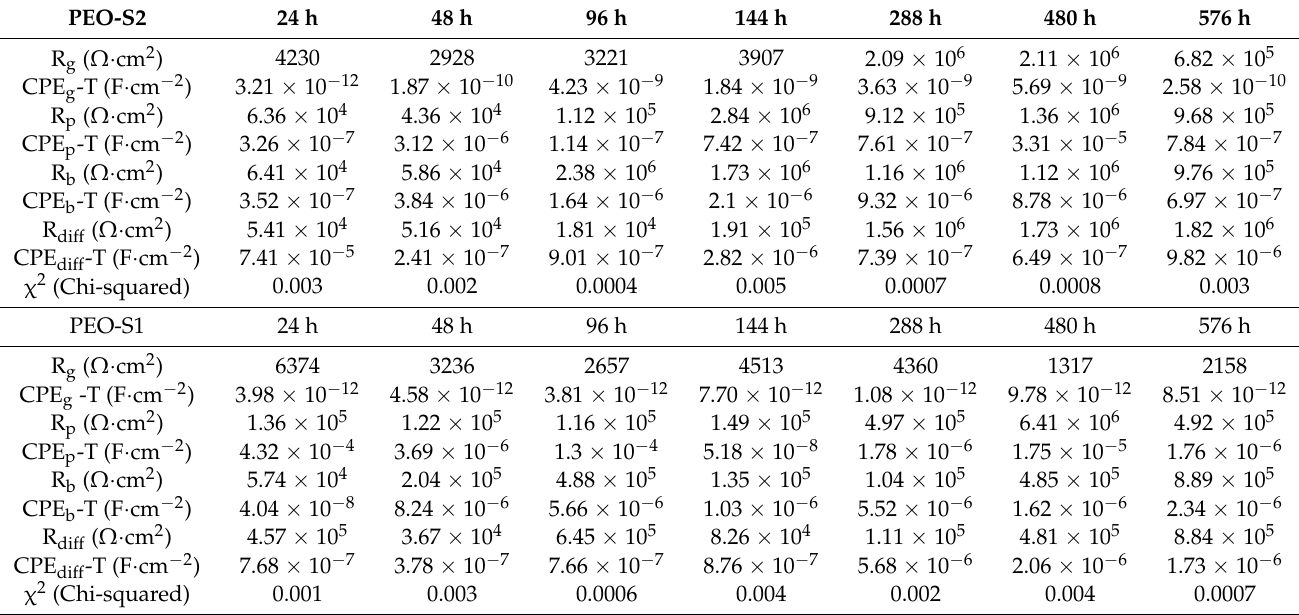
Table 3. The fitted results of EIS data simulations for PEO-silane-coated sample in a 3.5 wt.% NaCl